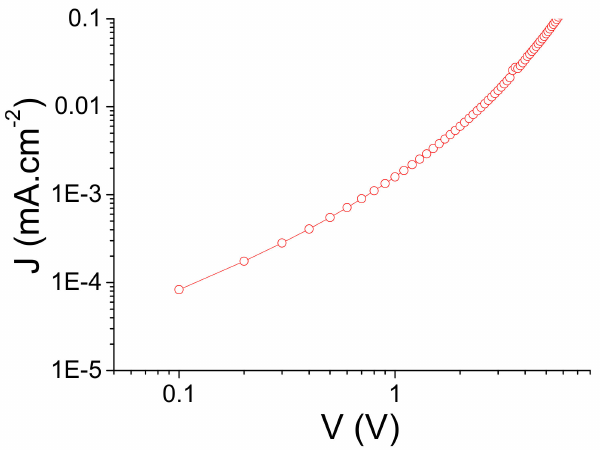
Figure 8. J–V characteristics of hole only devices ITO / PEDOT:PSS / BDT-C 60 /